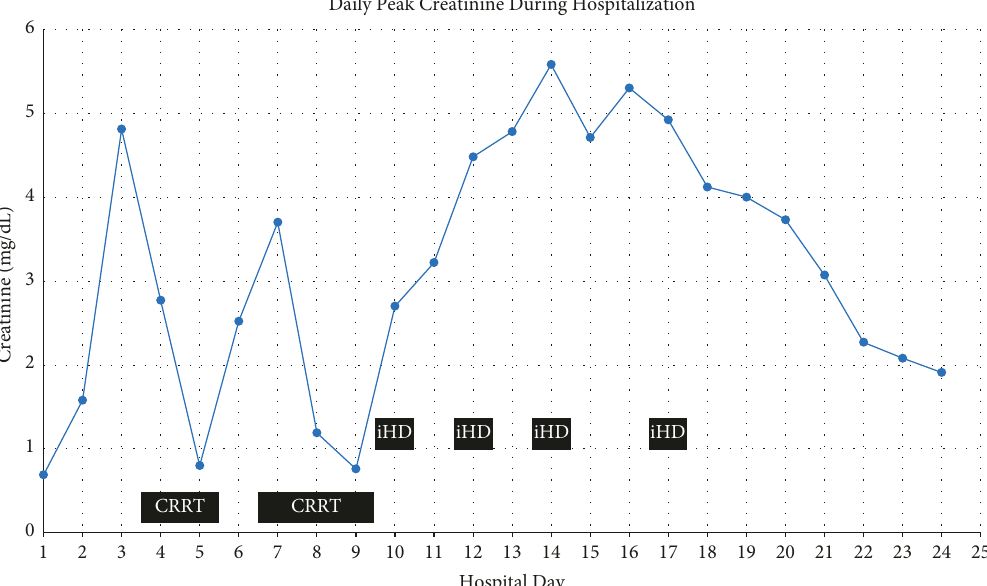
Figure 3: Peak creatinine trend in mg/dL throughout hospitalization. CRRT was initiated on hospital day 4, prior to the creatinine plotted for that day.